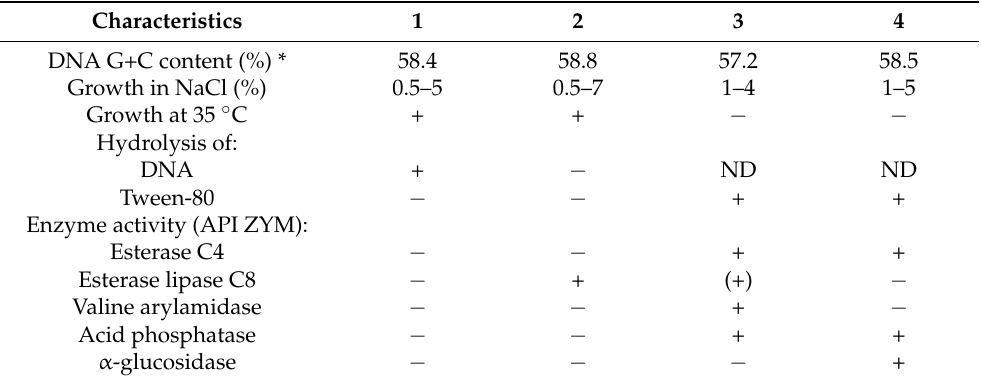
Table 1. Differential characteristics of strain KMM 9957 T and the type strains of most closely related Marinobacterium